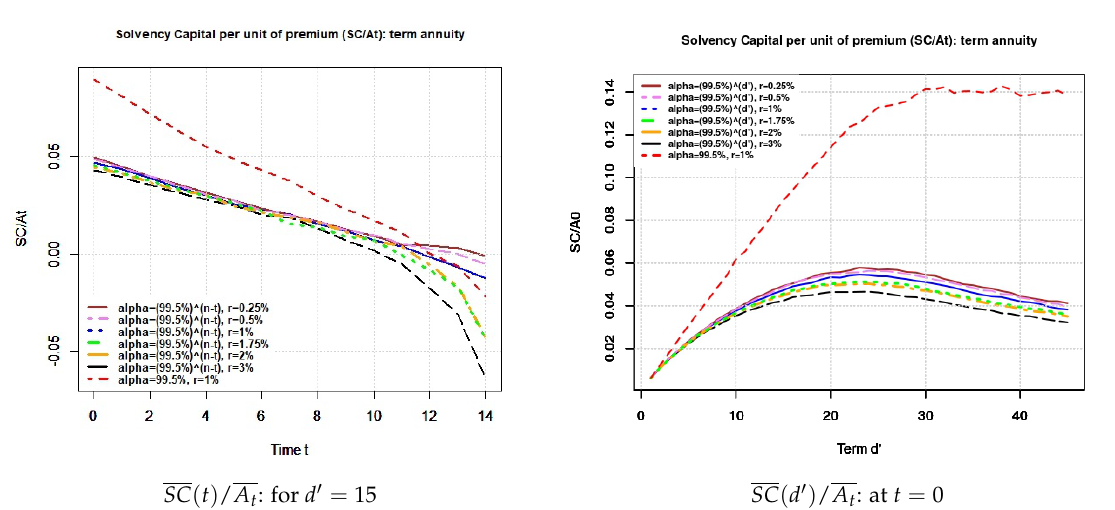
Figure 5. Term annuity; SC ( t ) and SC ( d (cid:48) ) respectively for different values of the short rate r and α